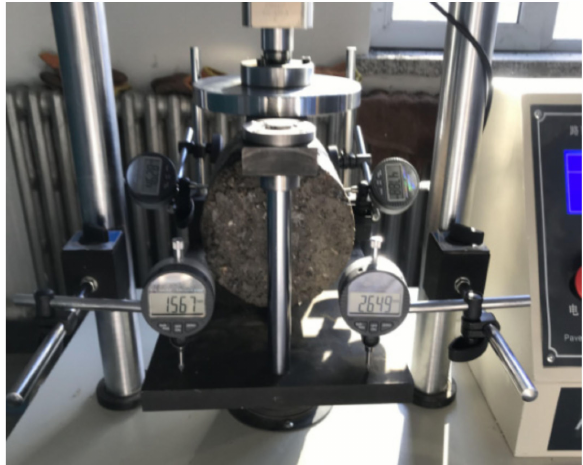
Figure 6. Lihuan pavement material strength tester